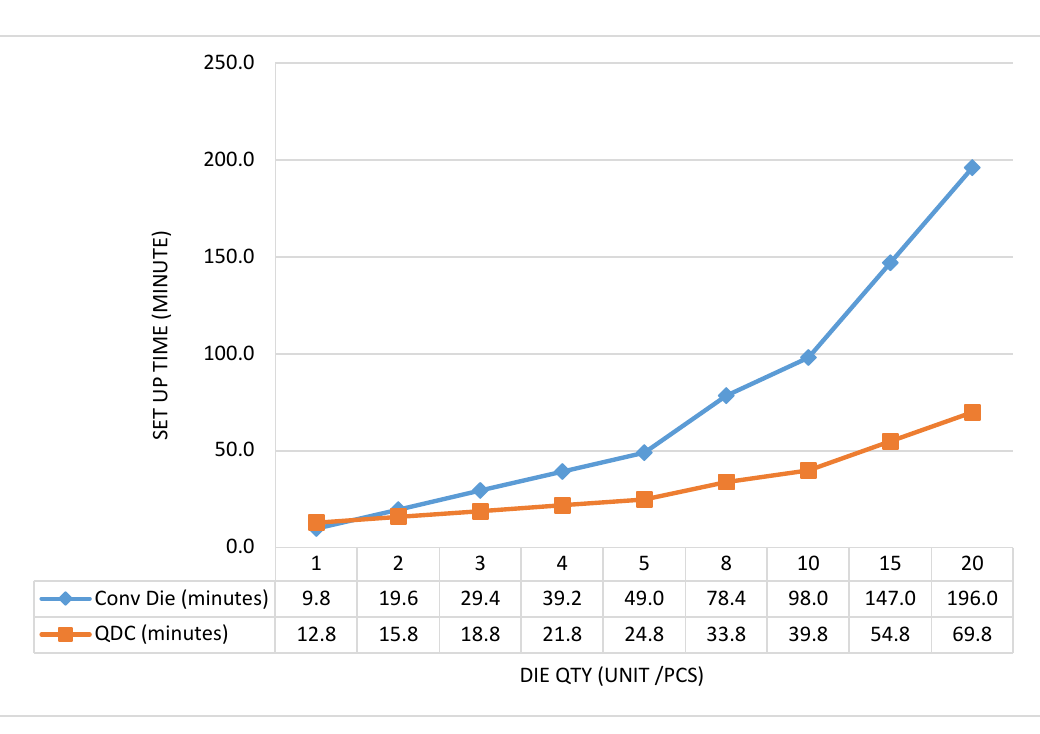
Figure 6: Efficiencies comparison’ chart, comparing setup time required for some number of